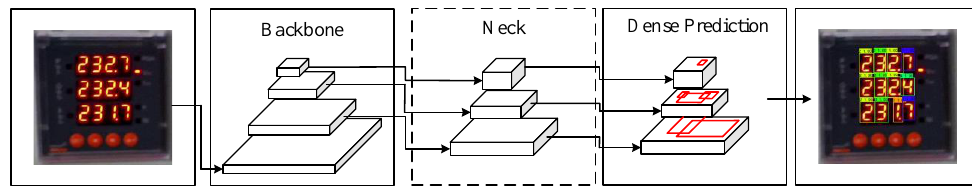
Figure 3. Dial area readings detection YOLOv4